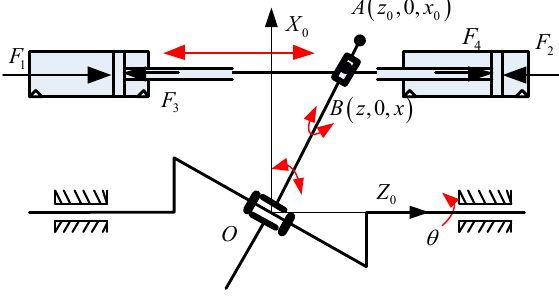
Figure 7. The kinematic diagram of the wobble plate joint.